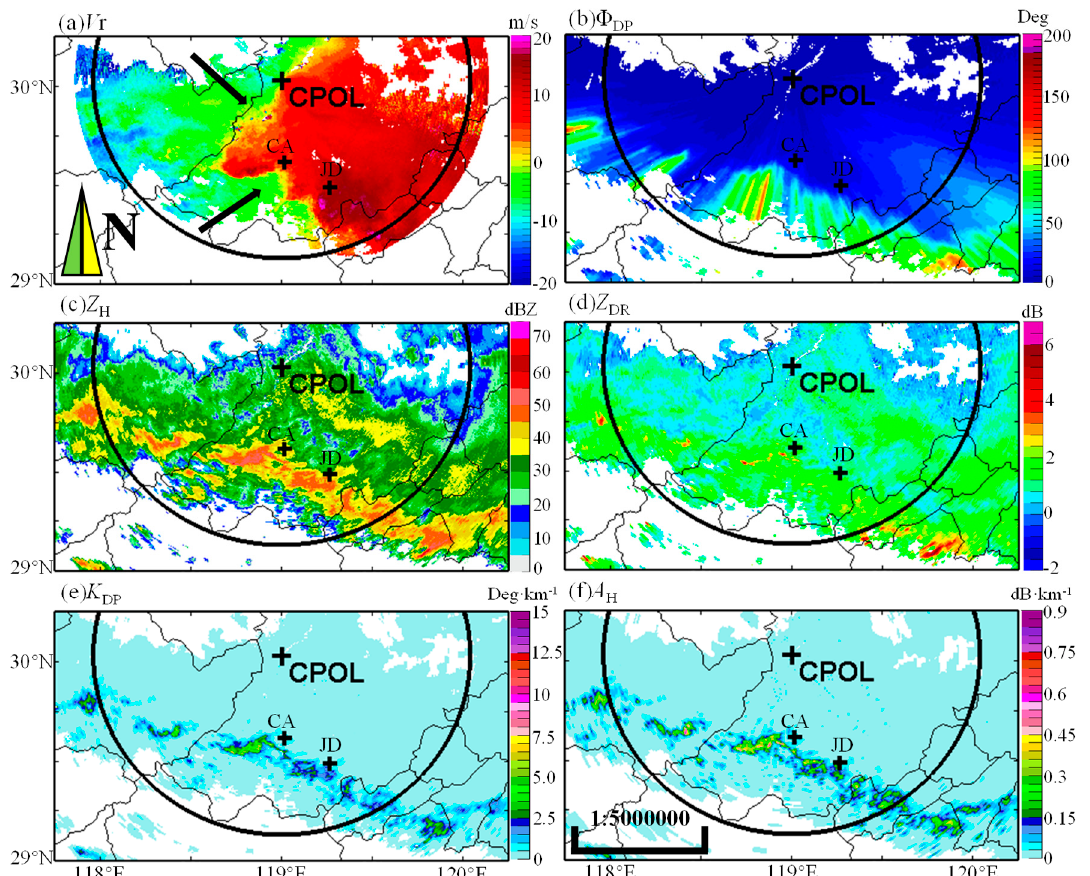
Figure 5. Radar plan position indicator (PPI) scan at an elevation angle of 0° at 0330 UTC on 1 June 2016: ( a ) V r; ( b ) Φ DP ; ( c ) Z H ; ( d ) Z DR ; ( e ) K DP and ( f ) A H . The relative positions of CA and JD are marked with “ + ”. The bold arrows in (a) describe the northwestern and the southwestern winds.